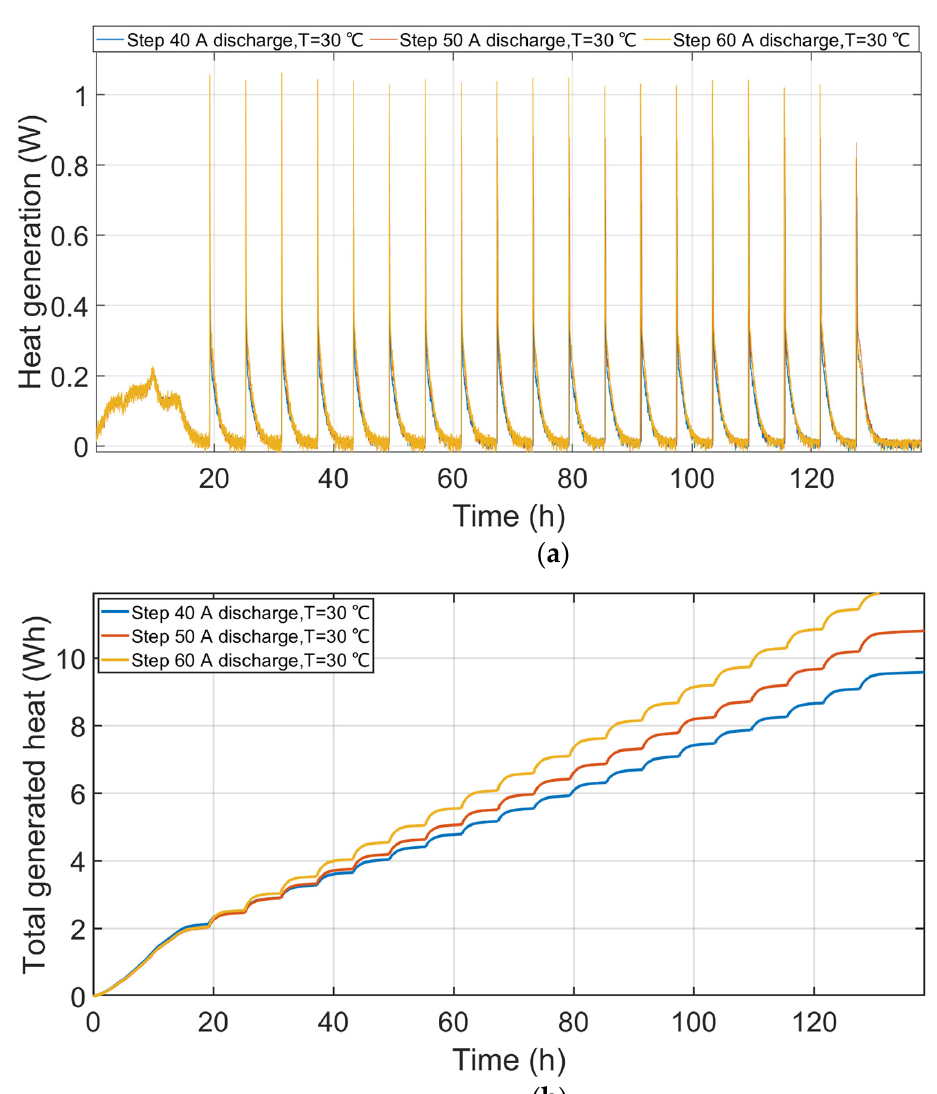
Figure 5. Thermal characterizations of a lithium titanate oxide-based lithium-ion battery, ( a ) heat generation evolution for case A, ( b ) total generated heat for case A.